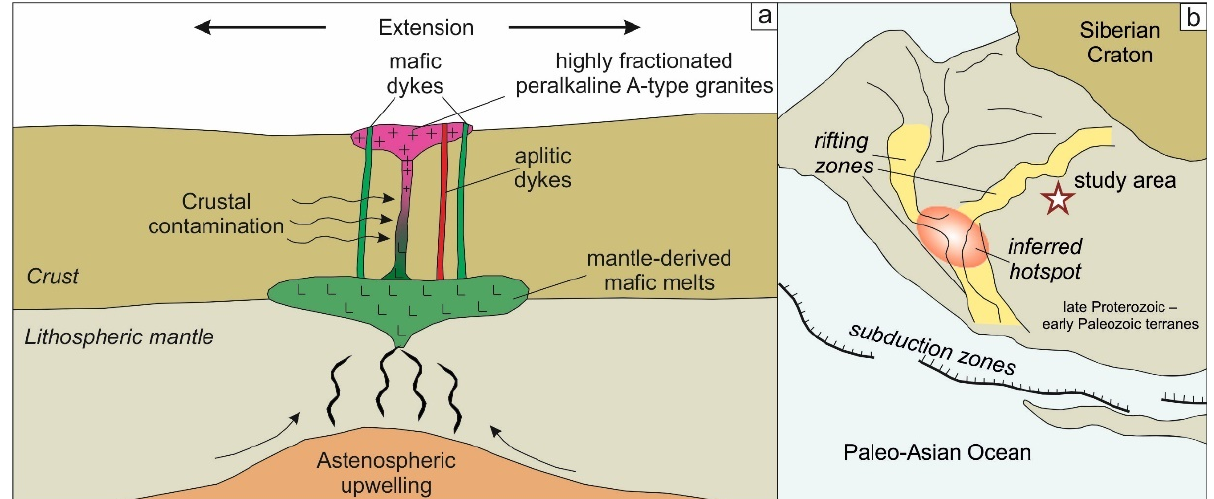
Figure 11. A geodynamic model showing evolution of the peralkaline A-type granitic and coeval mafic rocks of the Tannuola terrane ( a ) within the framework of geodynamic evolution of the northern Central Asian Orogenic Belt and ( b ) during Middle Devonian. Not to scale.